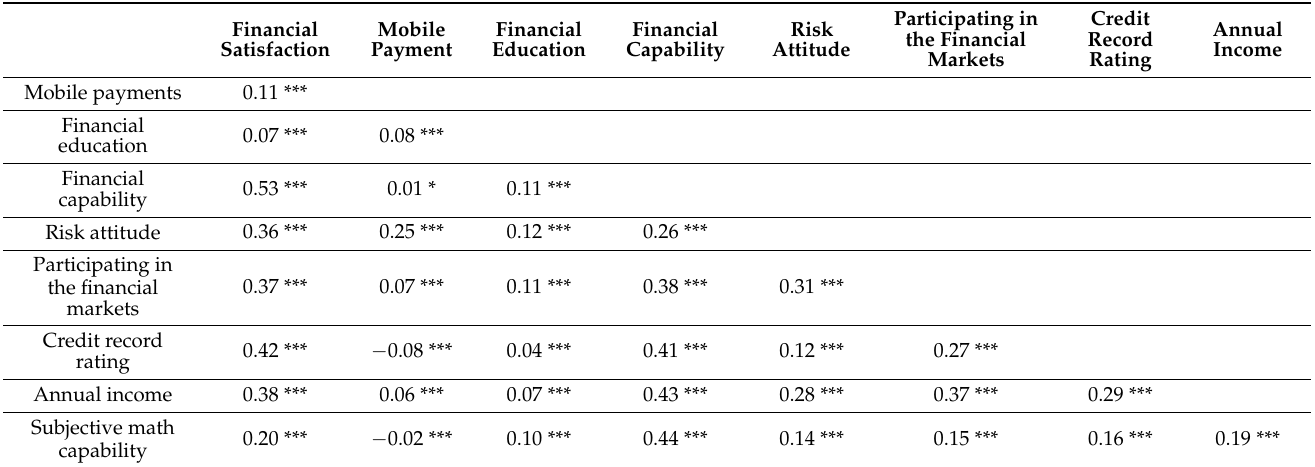
Table 3. Correlations between FinTech payment and consumer financial